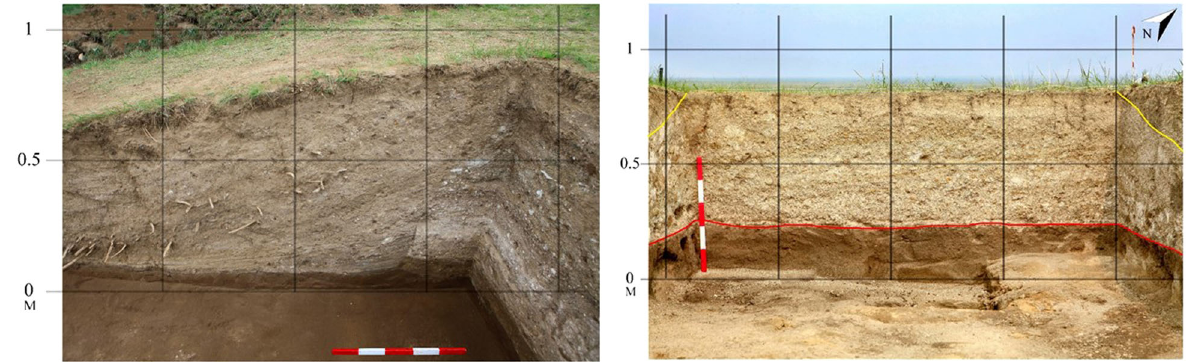
Fig. 5 Test excavations of enclosures at Cluster no. 24. Left: A section through the wall of the small internal rectangular enclosure showing tamped wall layers on the right side of the photo. Right: A section through the embankment of the circular enclosure with the base of the wall marked in red (Photo and processing by Tal